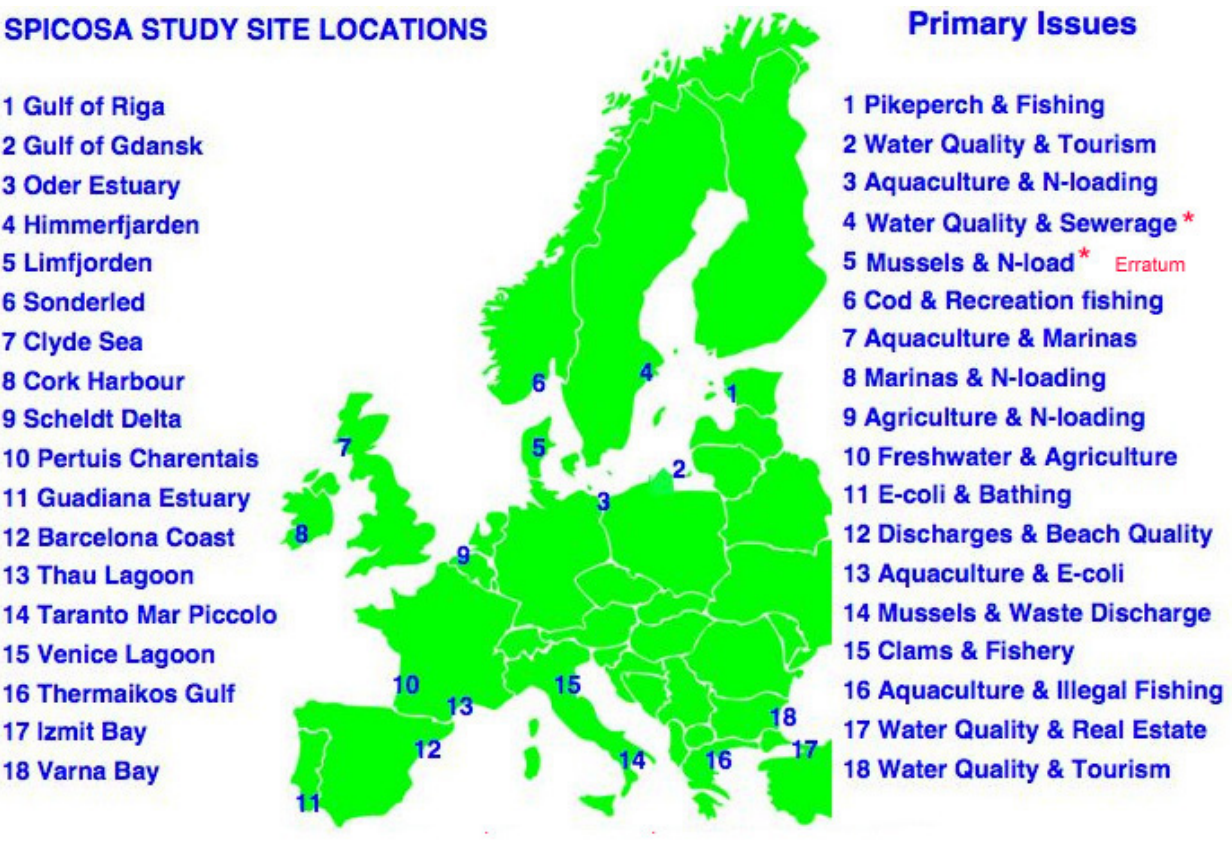
Fig. 4 . The locations of the study sites of the SPICOSA Project indicated by a counterclockwise sequence with the names of coastal zones and their primary issues considered. Erratum: In the original published version of Figure 4, study sites 4 & 5 were misidentified. The correction was made on 5 April